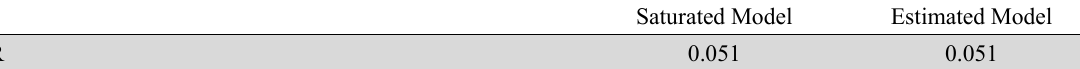
Table 4 shows that P-value of all relationships are lower than 0.05 whereas the table 5 indicates that Standardized Root Mean Square Residual (SRMR) is suitable for the research model. Hu and Bentler (1998) argue that SRMR should be lower than 0.08. Thus, hypotheses H1, H2, H3, H4, H5, H6, H7 are supported. The standardized regression equation is represented as